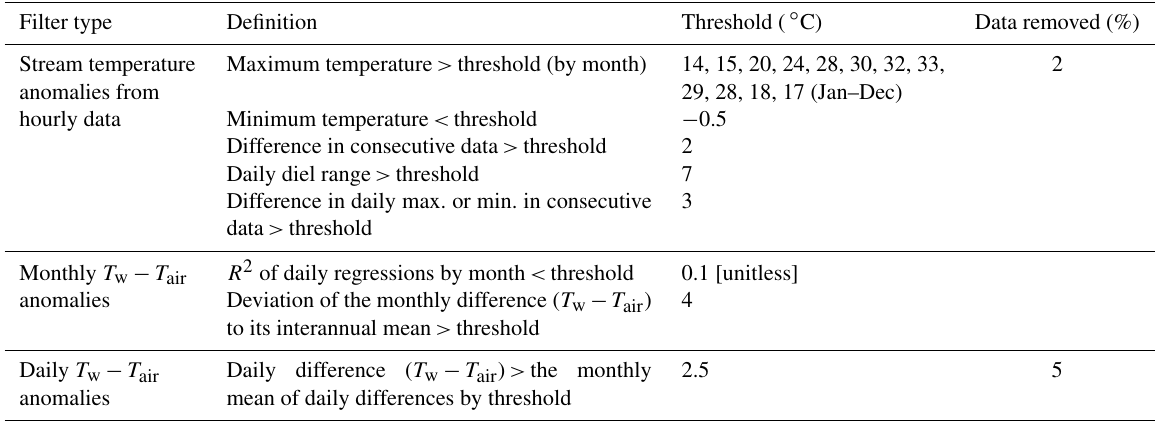
Table 1. Outlier detection and data filtering process of stream temperature dataset. Filter